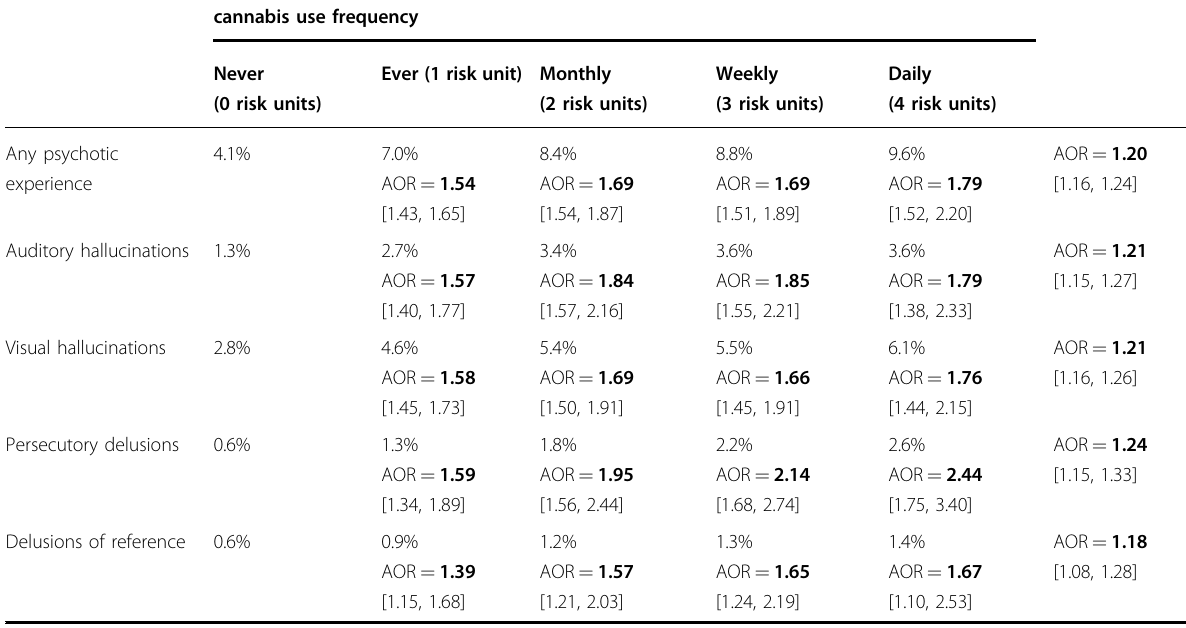
Table 2 Self-reported psychotic experiences are strongly associated with cannabis use